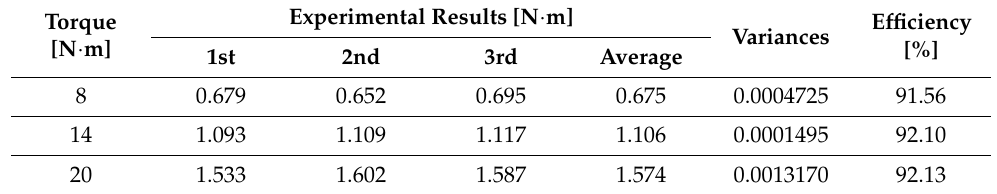
Table 8. Experimental results for second gear set.